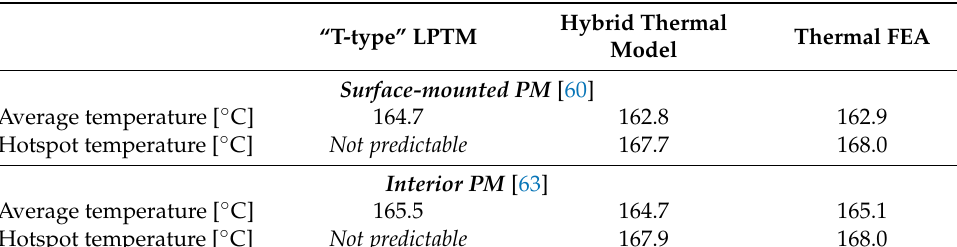
by main thermal analysis methods [60,63].